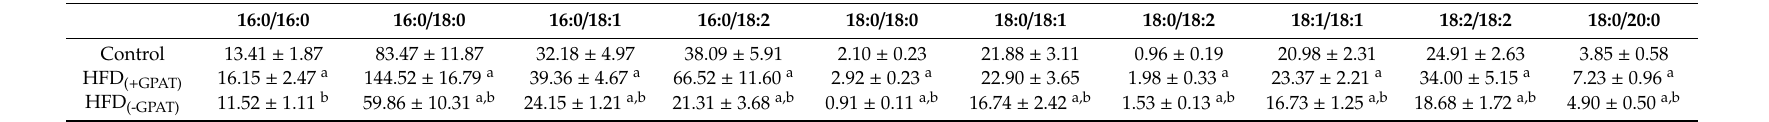
Table 2. The impact of GPAT silencing on the content of diacylglycerol molecular species in mouse gastrocnemius